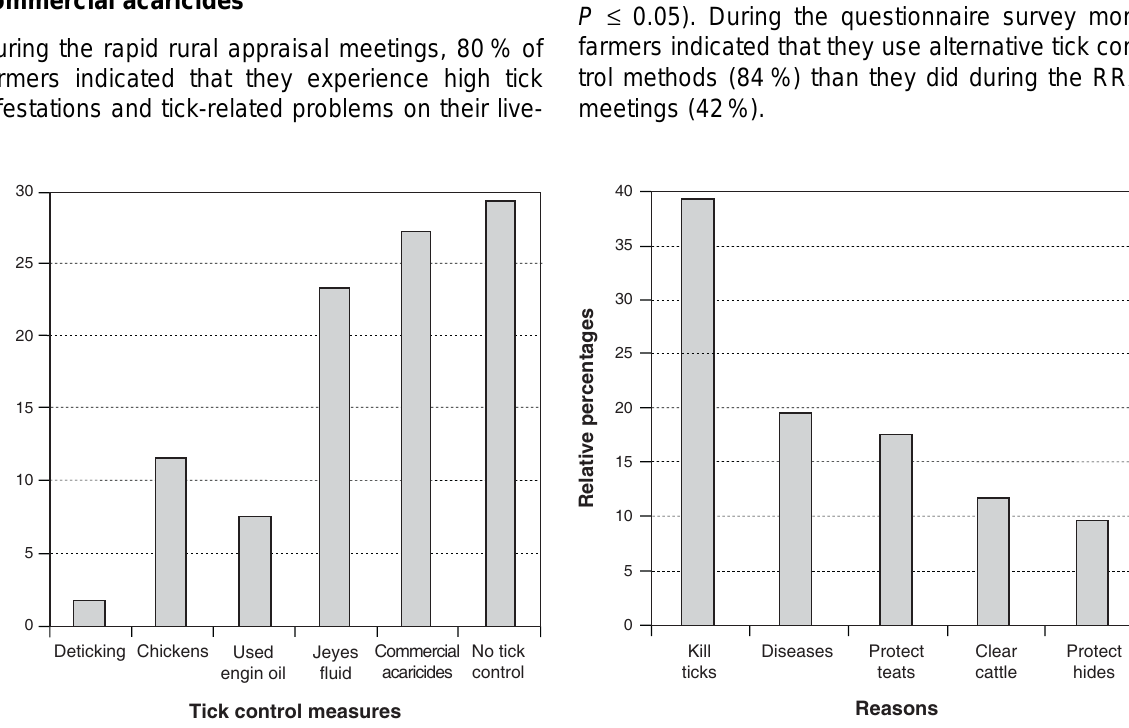
FIG. 2 Different tick control measures cited by resource-poor farmers of Qwa-Qwa during the RRA meetings between February and April 1998